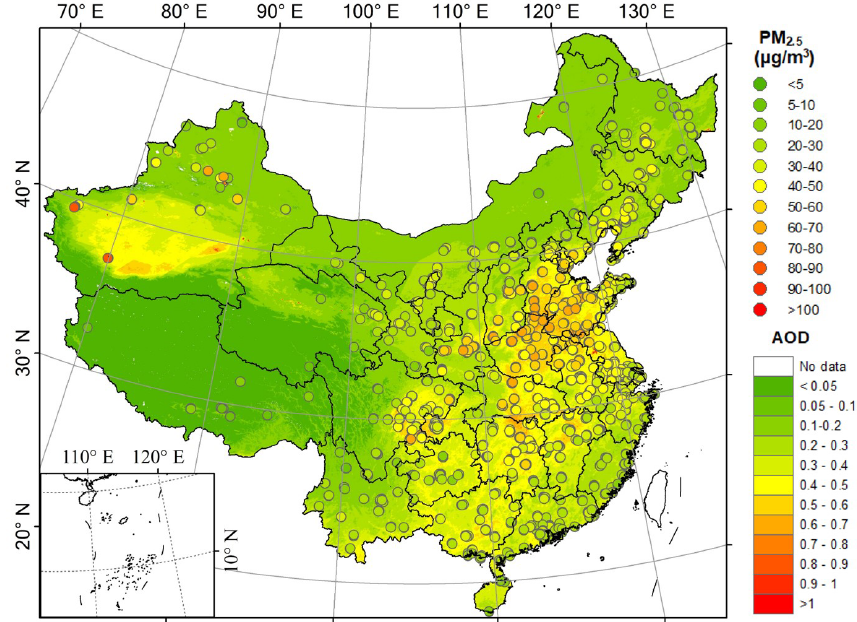
Figure 1. The spatial distribution of annual mean ground-level PM 2 . 5 and satellite AOD averages in China in 2019. The mean value of the ground-level PM 2 . 5 concentration was calculated from all measured days, covering almost the whole study period, whereas the mean AOD value was calculated using fewer days because the MAIAC algorithm could not make retrievals over areas with high cloud cover.